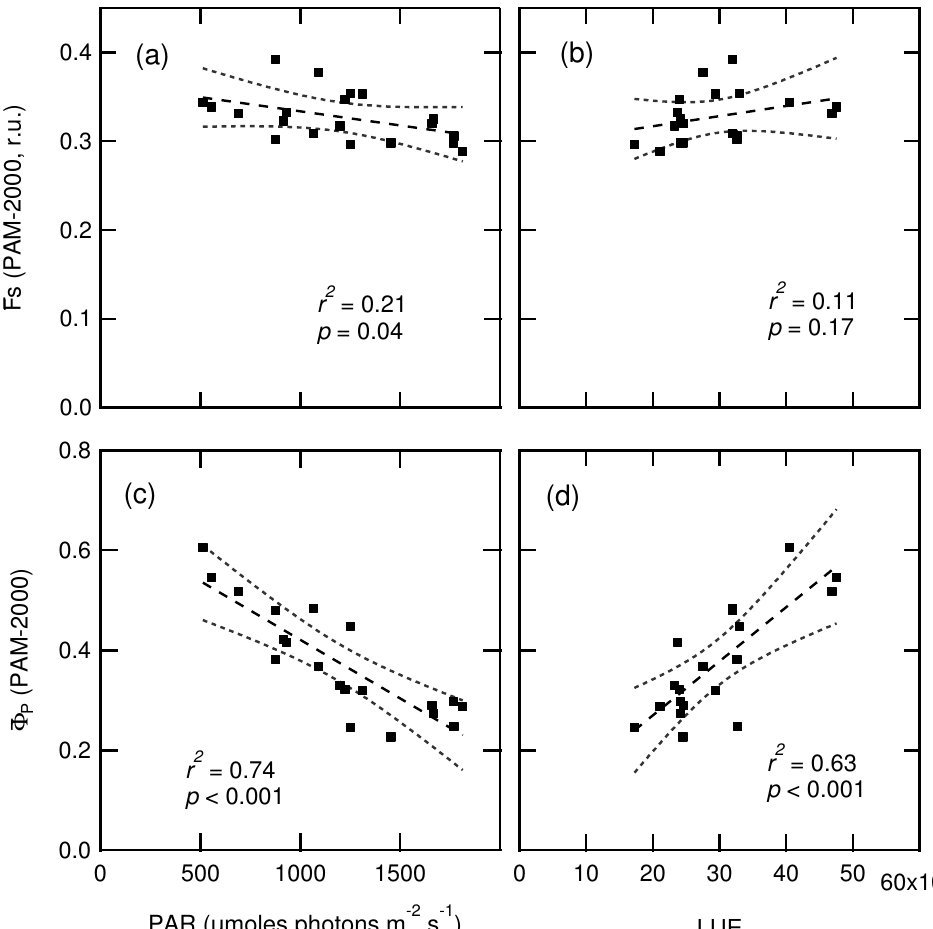
Figure 10. Scatter plots of stationary fluorescence level ( Fs ) and photochemical yield ( Φ P ) measured at leaf level with a PAM-2000 as a function of incident PAR and light use efficiency from EC measurements ( LUE = GPP / APAR ). r 2 values of the linear regression and p -values of the slope of the regression line are indicated. Regression line equations are (with ± 99% confidence intervals): ( a ) y = ( 0.368 ± 0.055 ) +( 33. ± 44. ) × 10 − 6 x , r 2 = 0.21; ( b ) y = ( 0.29 ± 0.07 ) + ( 1.14 ± 2.3 ) x , r 2 = 0.11; ( c ) y = ( 0.66 ± 0.13 ) − ( 0.23 ± 0.10 ) × 10 − 3 x , r 2 = 0.74; ( d ) y = ( 0.053 ± 0.18 ) + ( 10.8 ± 5.8 ) x , r 2 =